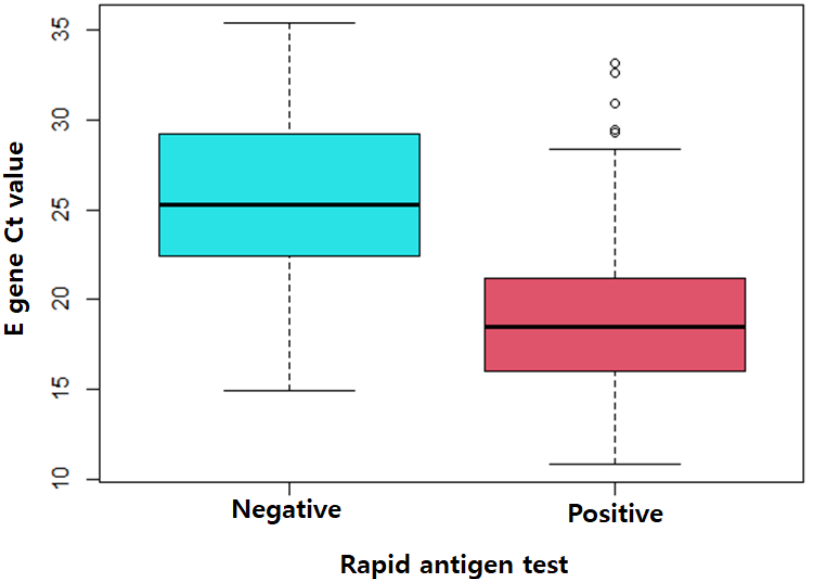
Figure 1. E gene Ct value of RT–PCR according to the rapid antigen test results in COVID-19 patients ( n = 348).